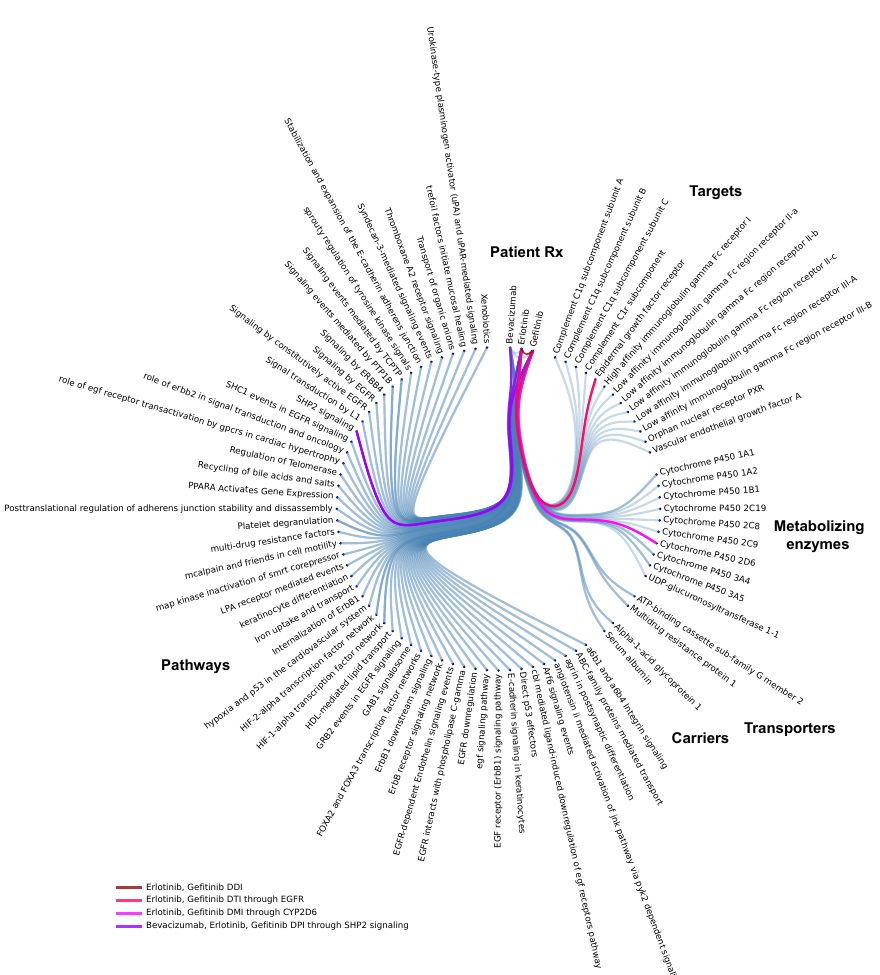
Figure 2. Systems-level analysis of drug-interactions: Example of an individual patient-specific case-model via a Molecular Dependency Graph: this systems pharmacology molecular model highlights co-occurrence of label-based, target-, metabolizing enzyme-, and pathway-level interactions in a single patient. This lung cancer patient’s model (FAERS #6703852) involves co-medication of erlotinib with gefitinib, a clinically problematic combination, probably due to overloading of the drug-binding site on the Epidermal Growth Factor Receptor (EGFR) within the target